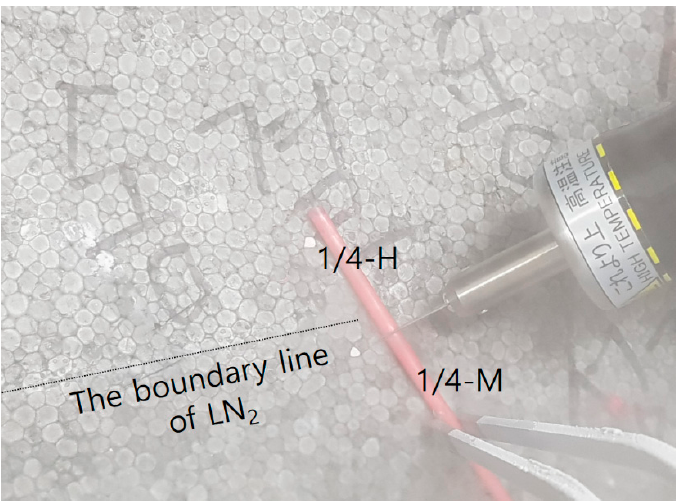
Figure 2. An image of the ultrasonic cutter on the frozen semen straw. The bottom of the tilted Styrofoam box was used to expose the cutting area of frozen semen to the surface of LN2.